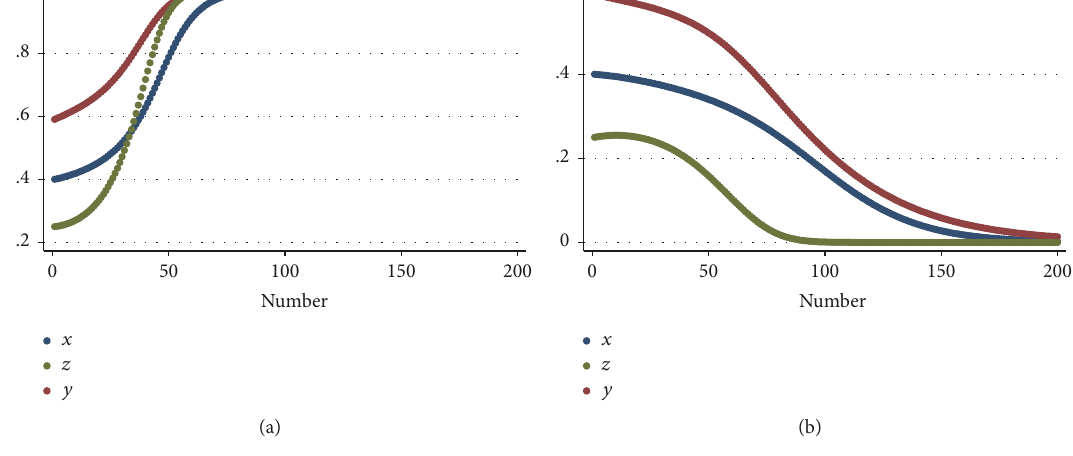
Figure 5: Simulation results when 𝑟 changes.